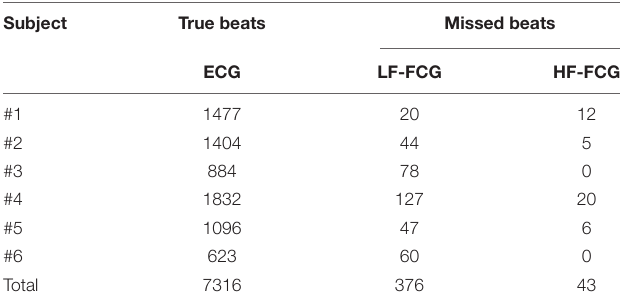
TABLE 2 | Heart beats detected in ECG and in the LF-FCG and HF-FCG components extracted from the raw piezoelectric sensor signal.